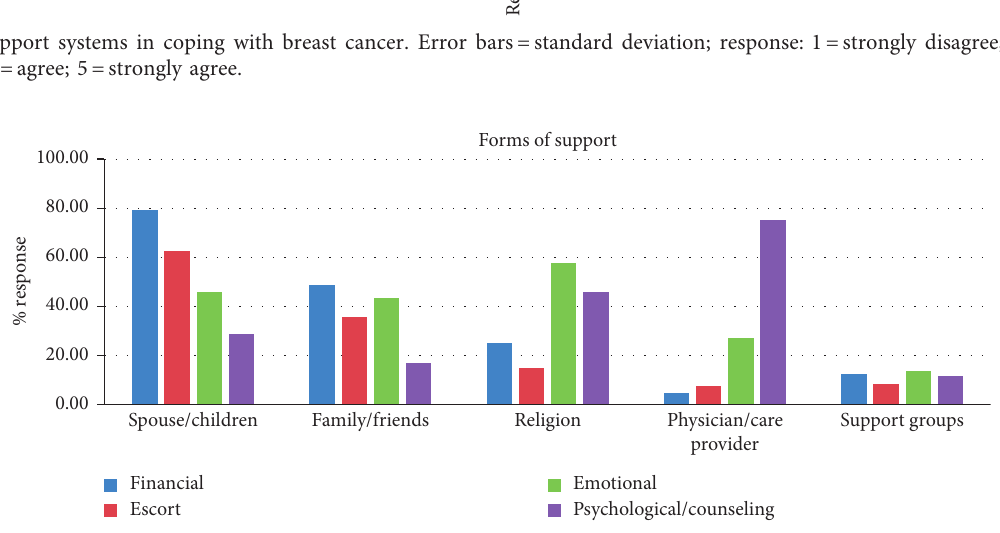
Figure 2: Forms of support received by women diagnosed with breast